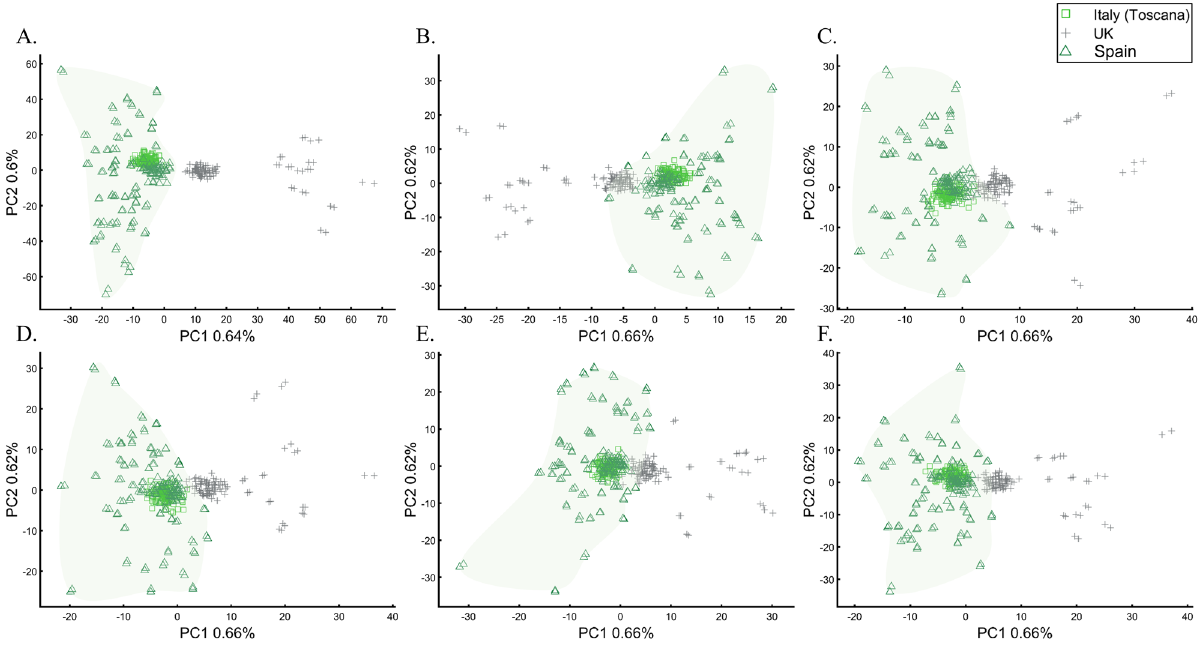
Figure 22. PCA of Tuscany Italians ( n = 115), British ( n = 105), and Iberians ( n = 150) across all markers ( p ~ 129,000) ( A ) and different marker types ( p ~ 30,000): ( B ) coding SNPs, ( C ) intronic SNPs, ( D ) protein- coding SNPs, ( E ) RNA molecules, and ( F ) upstream and downstream SNPs. Convex hull was used to generate the European